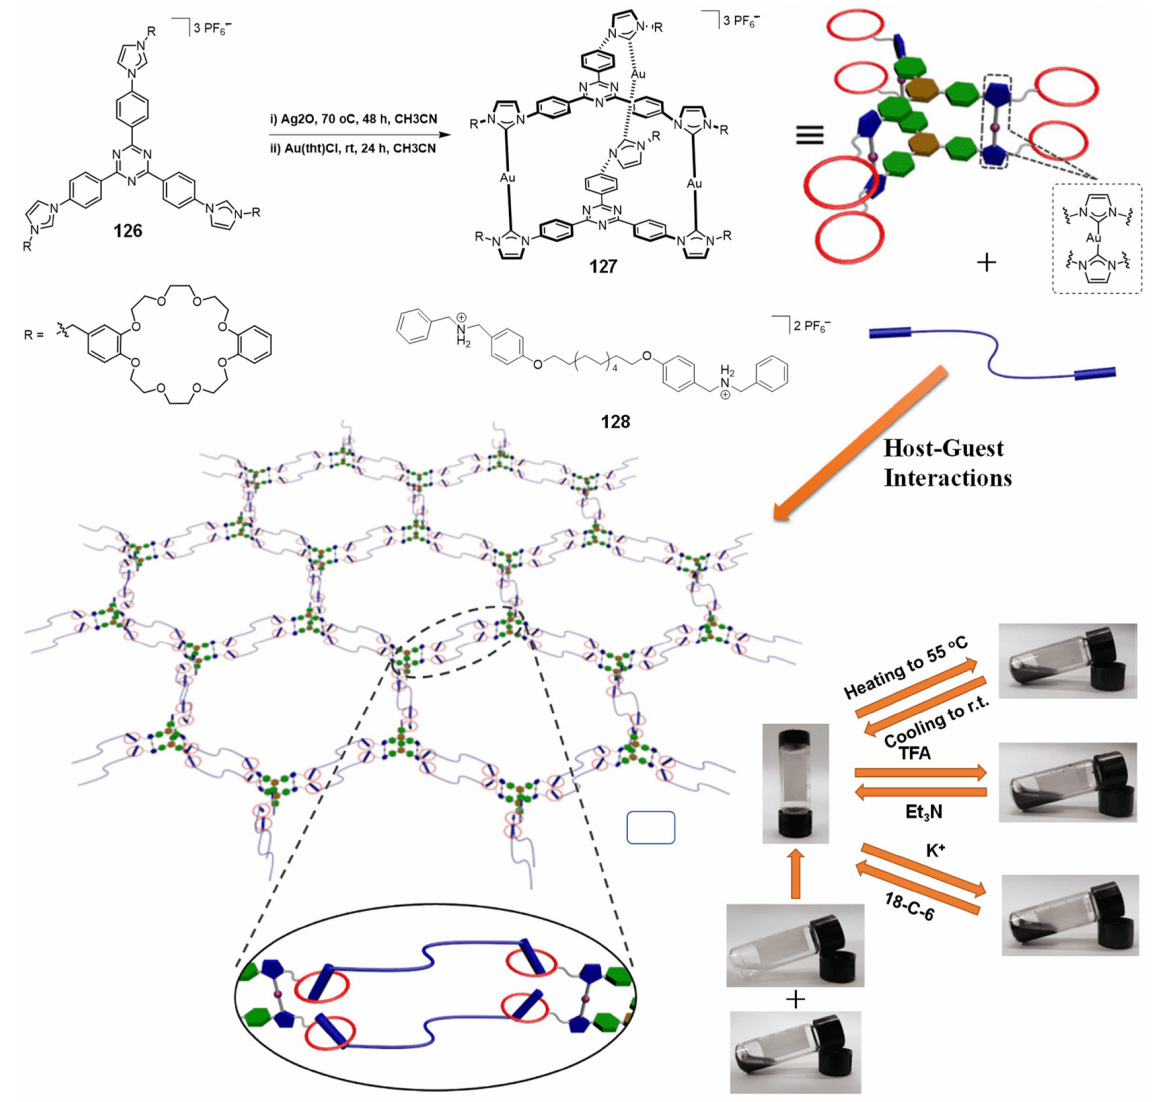
Figure 52. Formation of cross-linked supramolecular polymer network from trinuclear AuI hex- acarbene assembly 127 and bis-ammonium salt 128 , and the reversible gel–sol transition of the supramolecular gel. Reprinted with permission from Ref. [134]. Copyright (2021),